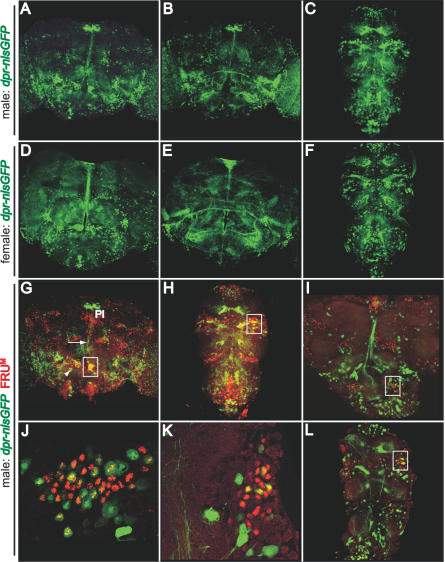

dpr Expression in the CNS Colocalizes with FRUM in Adults and 48-h Pupae and Is Not Sexually DimorphicIn all images, dpr-GAL4; UAS-nlsGFP (hereafter called dpr expression) is shown in green.(A–C) dpr expression in the 0–24-h adult male CNS. (A) Anterior brain z-section. (B) Posterior brain z-section. (C) Anterior ventral nerve cord z-section.(D–F) dpr expression in the 0–24 h adult female CNS. (D) Anterior brain z-section. (E) Posterior brain z-section. (F) Anterior ventral nerve cord z-section.(G–H) dpr and FRUM (red, immunohistochemistry) expression in the 0–24-h adult male CNS. (G) dpr and FRUM expression in the anterior male brain. Colocalized expression of dpr (green) and FRUM (red) is observed in the median bundle neurons (white box). dpr is expressed in cells in the axonal tract extending from the median bundle (arrow), and in the pars intercerebralis (PI). (H) dpr and FRUM expression in the 0–24-h adult male ventral nerve cord. Colocalized expression of dpr (green) and FRUM (red) is observed in the first thoracic ganglion (white box). (J) dpr (green) and FRUM (red) expression in 40× magnification of median bundle neuron region (white box in [G], independent brain). (K) dpr (green) and FRUM (red) expression in 40× magnification of first thoracic ganglion region (white box in [H], independent VNC). dpr and FRUM expression in the 48-h pupal male brain (I) and ventral nerve cord (L). Z-section thickness was ∼1 μm for (A–I), (L), and ∼0.5 μm for 40× images (J–K).doi:0.1371/journal.pgen.0030216.g006